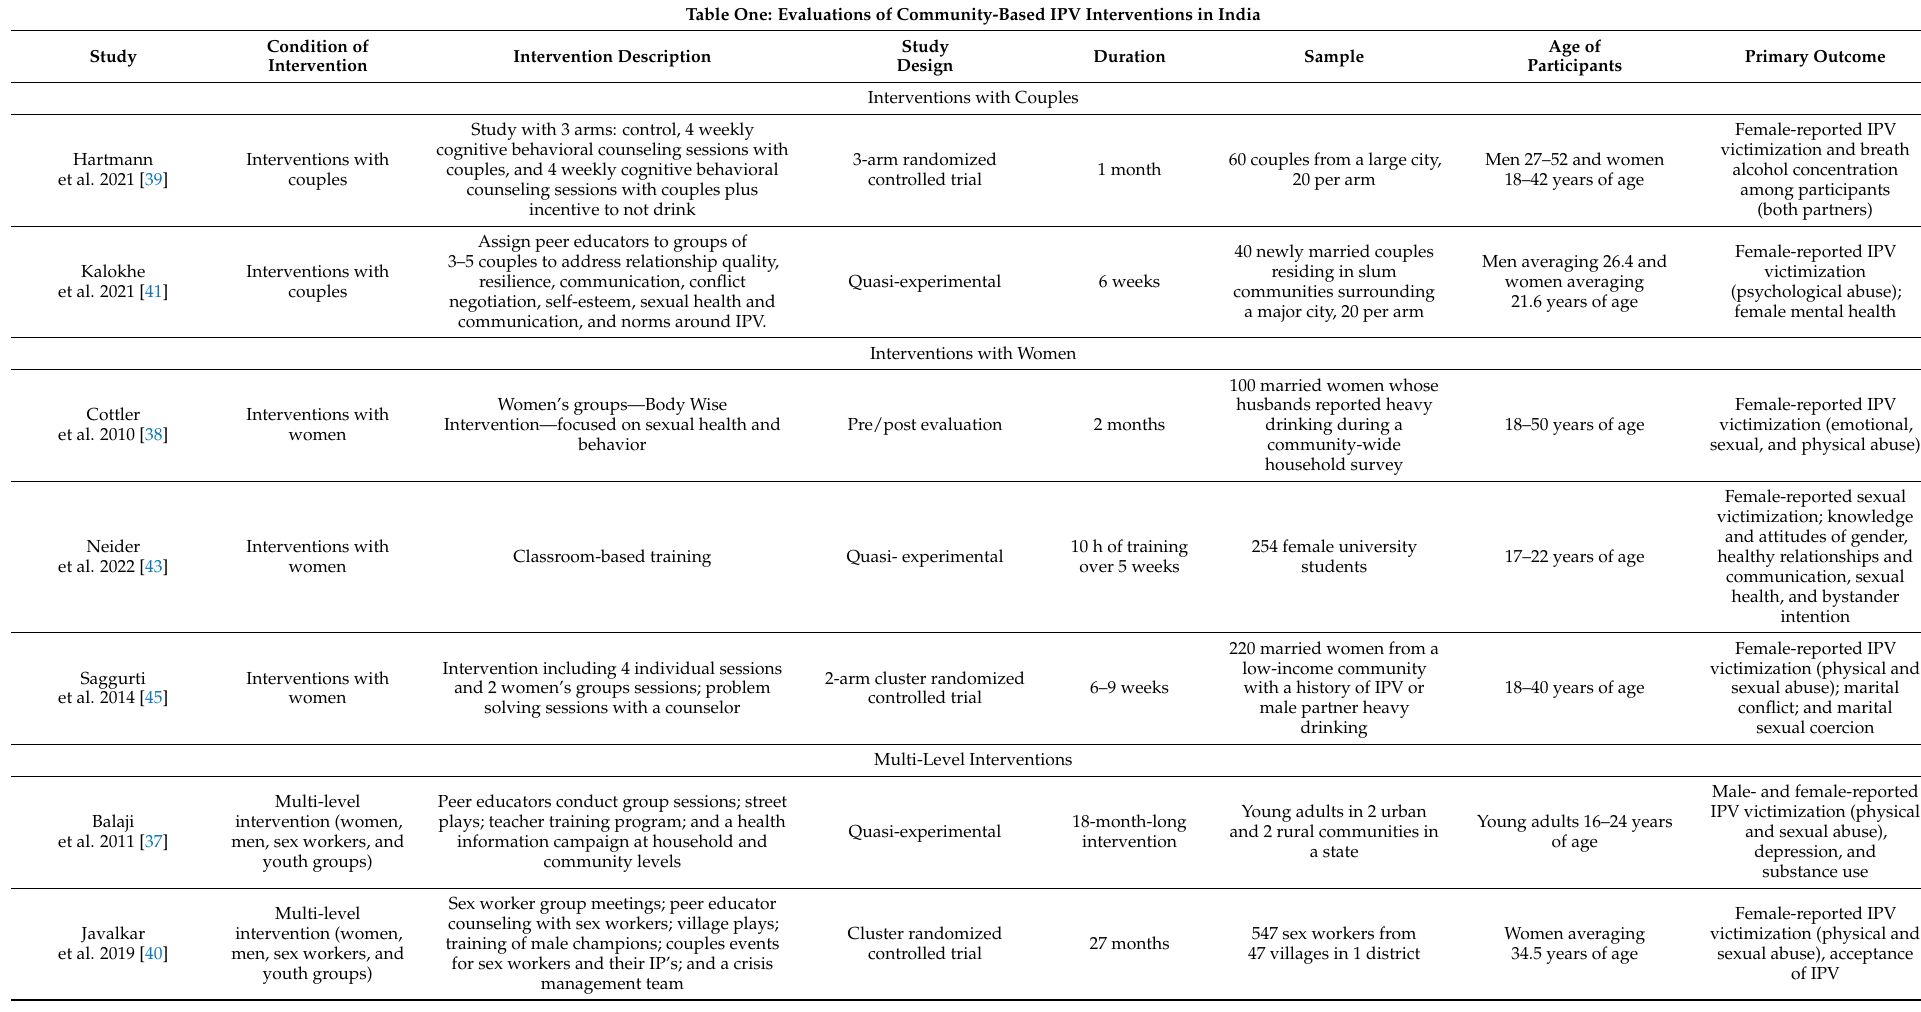
Table 1. Evaluations of community-based IPV interventions in India. Table One: Evaluations of Community-Based IPV Interventions in